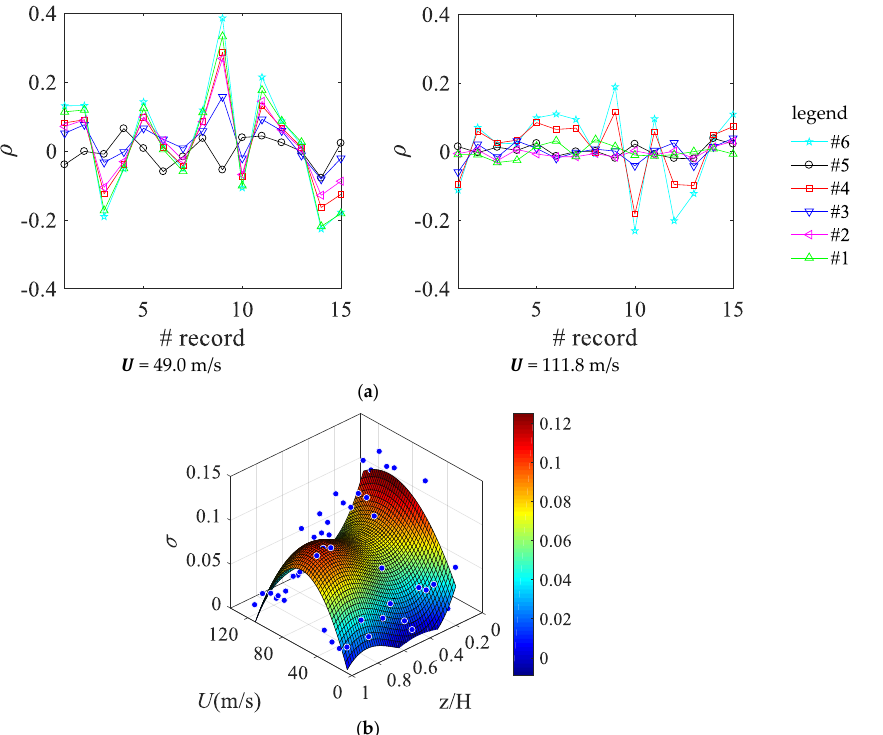
Figure 11. Variability of the correlation coefficient at different levels between along and across wind ( a ) and the standard deviation as a function of wind velocity and building levels ( b ). The standard deviation ranges from 0.01 to 0.15, taking its maximum value at low wind velocity levels, in the range from 40 m/s to 80 m/s. Figure 12 shows the CDF of the correlation coefficient estimated between level #6 and levels from #1 to #5. Figure 12 shows that, for U = 49.0 m/s, the GEV distribution gives the best fitting of the empirical CDF even if, as with the eigenvectors, the KS tests accepted the null hypothesis of inequality for all numerical CDFs.